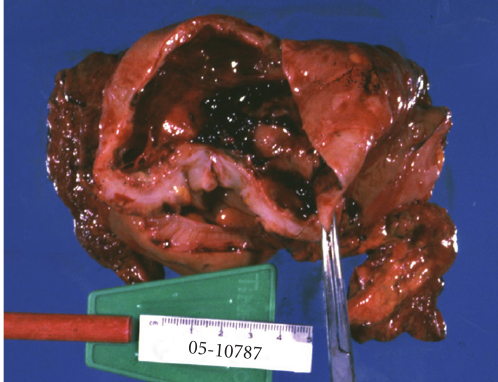
Figure 3: The duplication cyst opened, containing a small amount of blood clots.